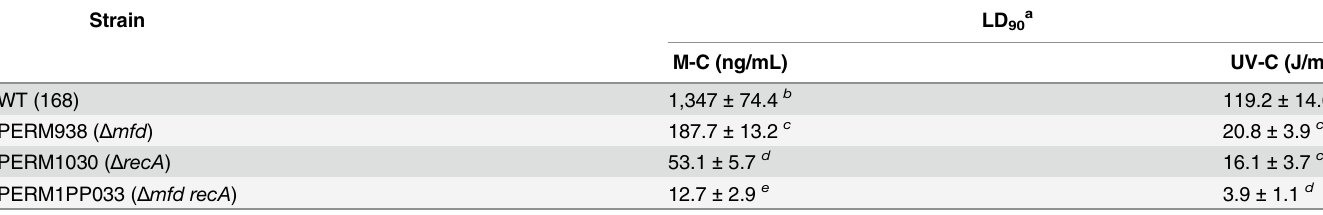
Table 2. Killing of B . subtilis forespores of various strains by DNA-damaging treatments.